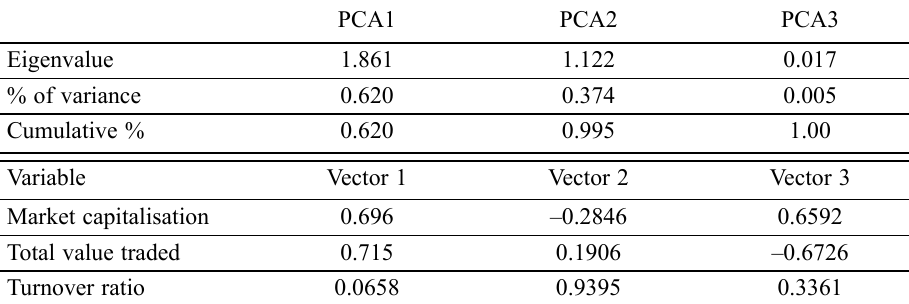
Table 4. Principal component analysis for stock market development index